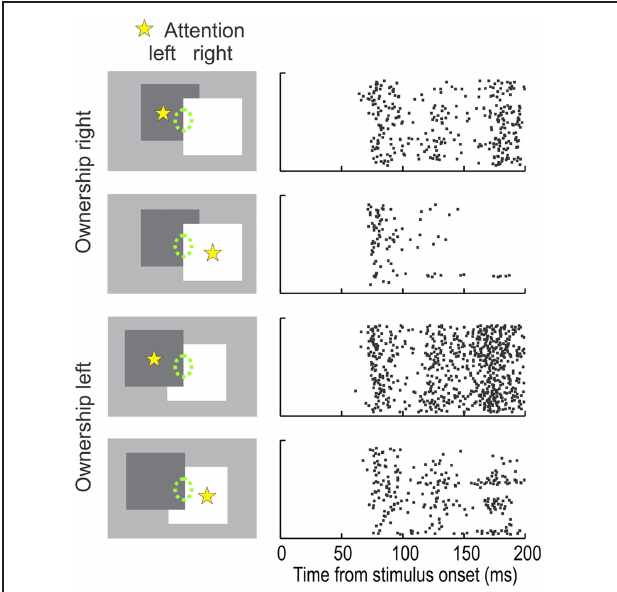
FIGURE 4 | The influence of attention on the responses of a typical border ownership selective neuron. The receptive field of the neuron ( green ellipse , not part of display) was placed on the border between two overlapping figures. In one configuration ( rows 1 and 2 ) this ‘occluding edge’ is owned by the square on the right, in the other configuration ( rows 3 and 4 ) it is owned by the square on the left. Attention was controlled by having the monkey perform a shape discrimination task with one of the figures (according to preceding instruction). The attended figure is marked here by a yellow asterisk (not part of display). ‘Left’ border ownership produced stronger responses than ‘right’ border ownership in both attention conditions. Interestingly, the attention effect was also asymmetric. Attention on the left figure enhanced the responses compared to attention on the right figure, irrespective of border ownership (compare rows 1 and 2 and rows 3 and 4 ). This asymmetry of the attention influence was systematic across the population: attention enhanced responses on the preferred border ownership side, relative to attention on the non-preferred side. (Modified from Qiu et al.,